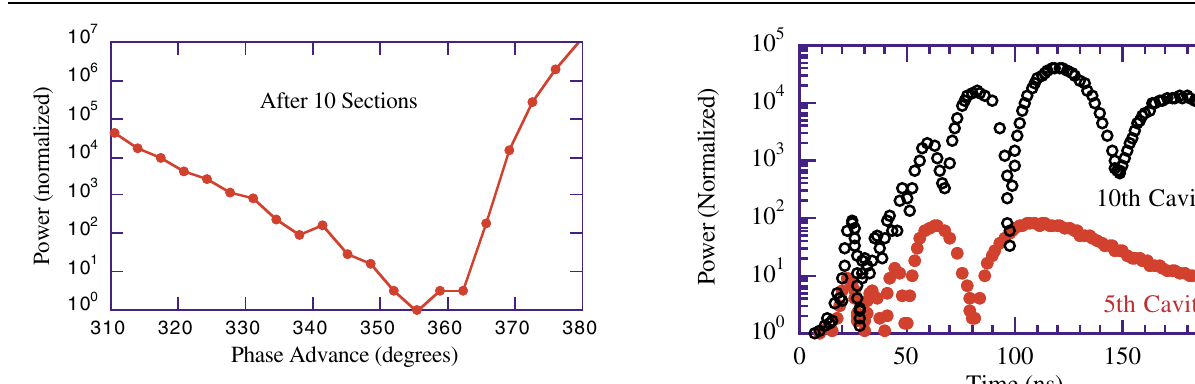
FIG. 2. (Color) Simulation of expected growth for the trans- verse instability in the BNS